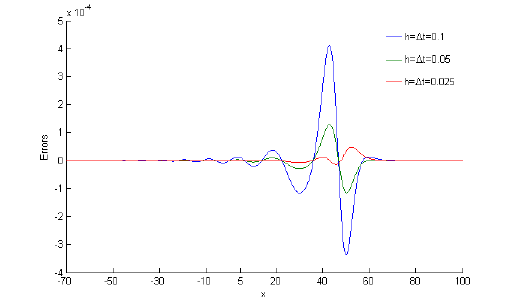
Figure 2. Errors for a = b = c = 1, d = 0 . 5, v = 1 . 18, different values of h and ∆t at t =